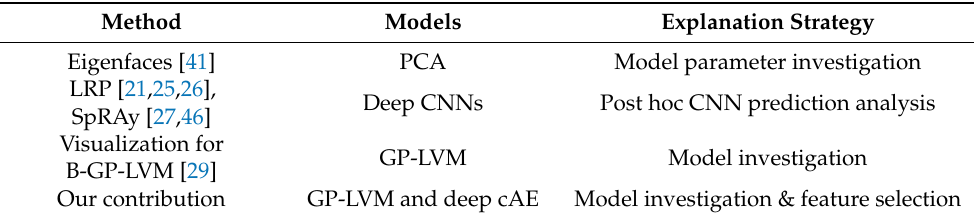
Table 1. Summarized explanation methods for machine learning based computer vision models.